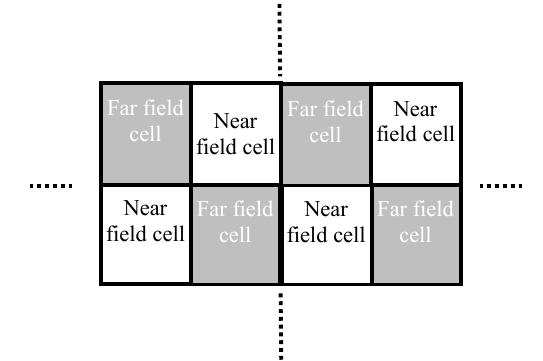
Figure 8: Principle of chess board plan for dual focus (FF/NF) transmitarray design.